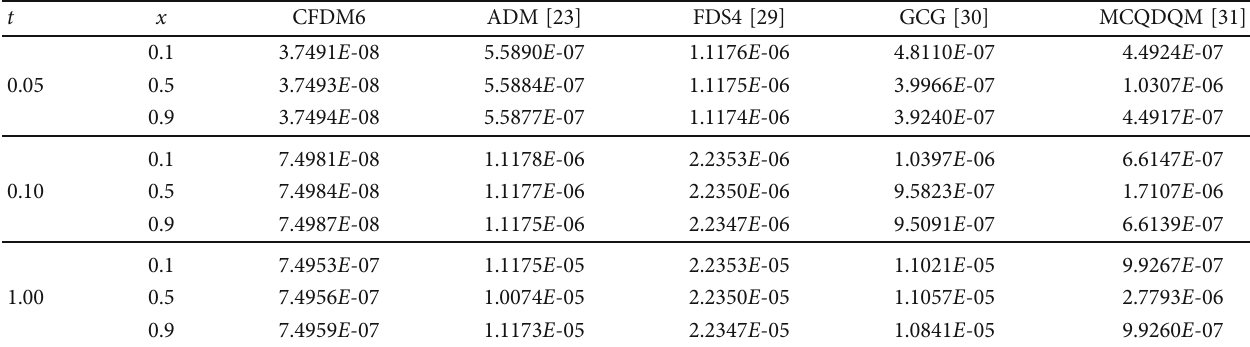
Table 11: Comparison of absolute error of Example 7 with β = 0 , γ = 1 , η = 0 : 001 , δ = 2 , h = 0 : 1 , and Δ t = 0 : 0001 :